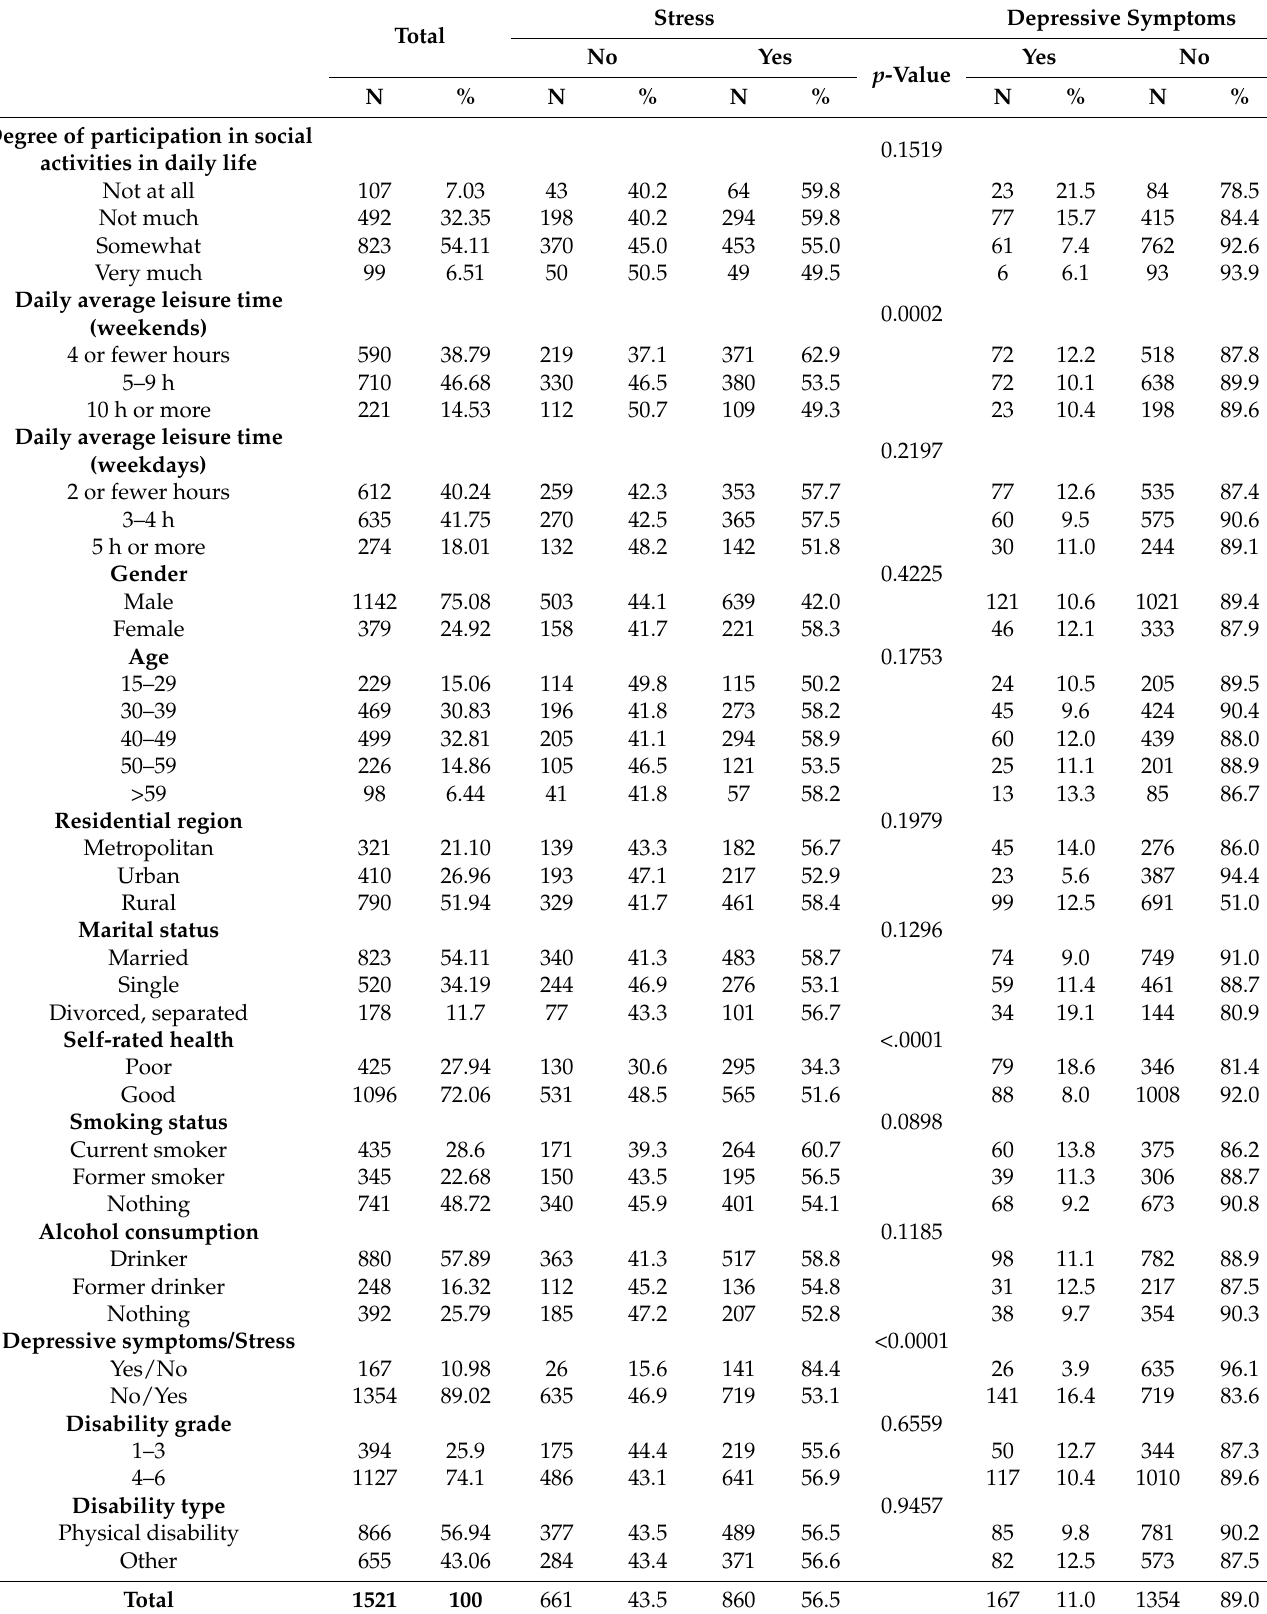
Table 1. General characteristics of subjects included for analysis at